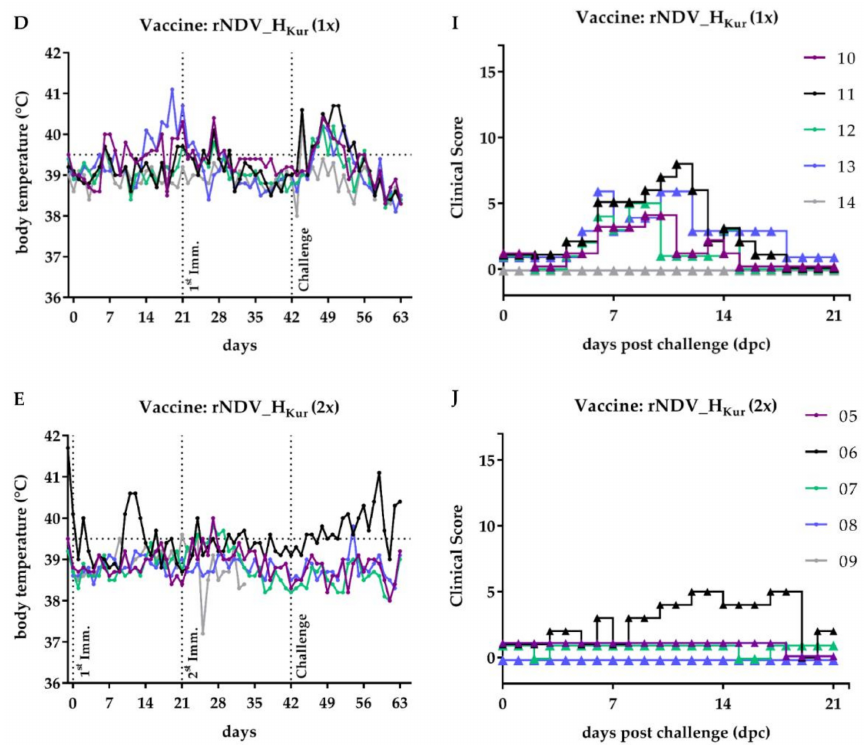
Figure 6. Body temperature and clinical course. ( A,F ) Five goats each were either left unvaccinated, ( B,G ) double inoculated with rNDV, ( C,H ) single vaccinated with PPRV Nigeria 75 / 1, ( D,I ) single vaccinated with rNDV_H Kur , or ( E,J ) double vaccinated with rNDV_H Kur . All goats were infected with PPRV Kurdistan / 11 three weeks after immunization. ( A–E ) Rectal body temperatures were monitored daily, beginning one day prior to the first immunization. ( F–J ) Clinical signs were assessed daily for three weeks after challenge infection and the clinical scores calculated as described in Section